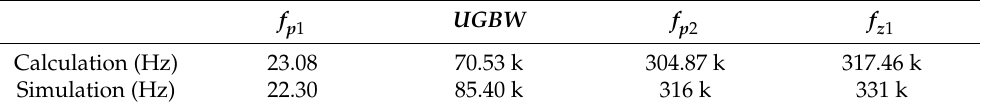
Figure 8. Loop Gain and Loop Phase of Reference Circuit. Table 4. Simulated and Calculated Values of Poles, Zeros and Unity-gain Bandwidth.